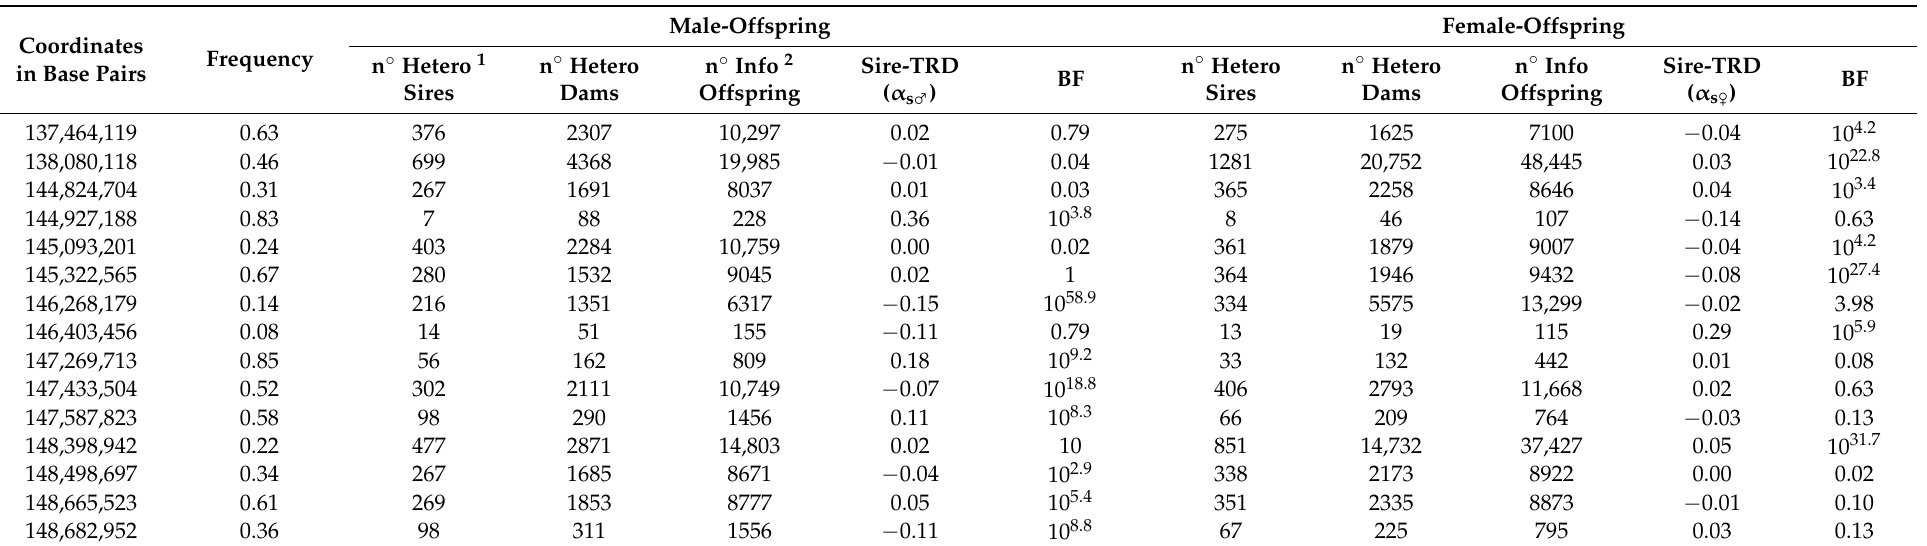
Table 1. Specific sex-offspring for sire-TRD in Holstein